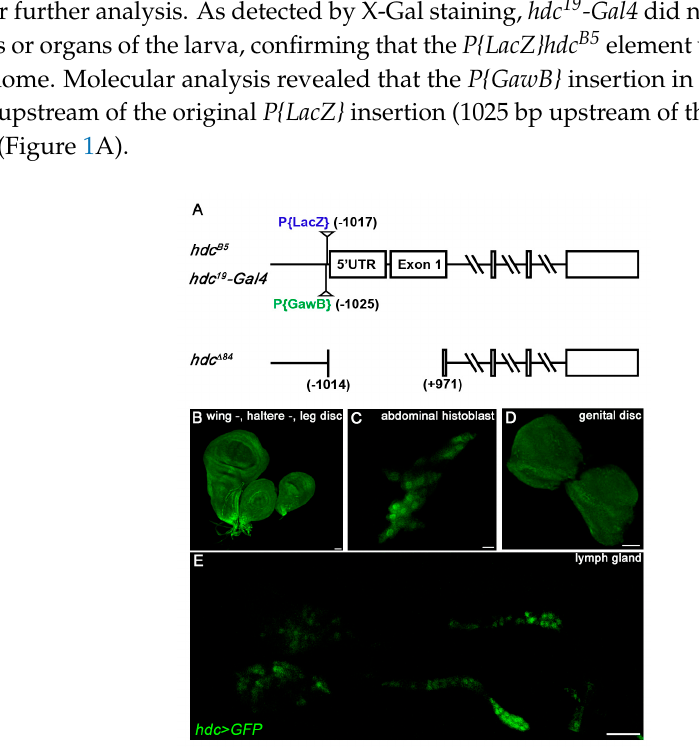
Figure 1. Genomic locations of hdc alleles and the expression pattern of hdc > GFP . ( A ) Molecular map of the hdc gene region. The positions of the original hdc B5 insertion, the hdc 19 -Gal4 insertion, and the breakpoints of the hdc ∆ 84 deletion are indicated; ( B – E ) hdc 19 -Gal4>GFP (green) was expressed in the imaginal discs ( B ), the abdominal histoblasts ( C ), the genital disc ( D ), and in the lymph gland ( E ) of the larva. Images were taken with Leica TCS SP5 Confocal Microscope, original magnification × 20 ( B , E ) and × 40 ( C , D ), and processed with LAS AF Lite (Leica Microsystems CMS GmbH), ImageJ and Adobe Photoshop CS2 software. Scale bars: 25 µm.